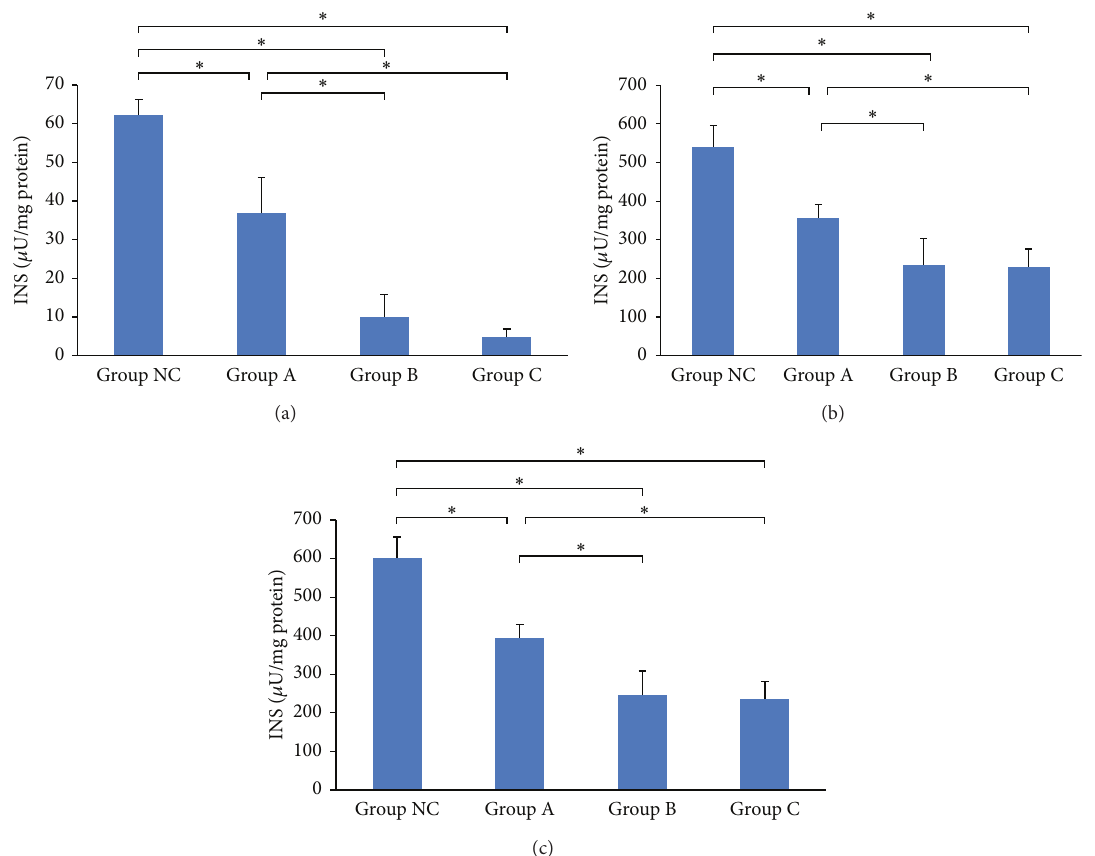
Figure 1: Effects of simvastatin on insulin content at low glucose levels. (a) Insulin secretion. (b) Insulin content in MIN6 cells. (c) Total amount of insulin. INS indicates insulin-releasing test. ∗ 𝑃 < 0.05